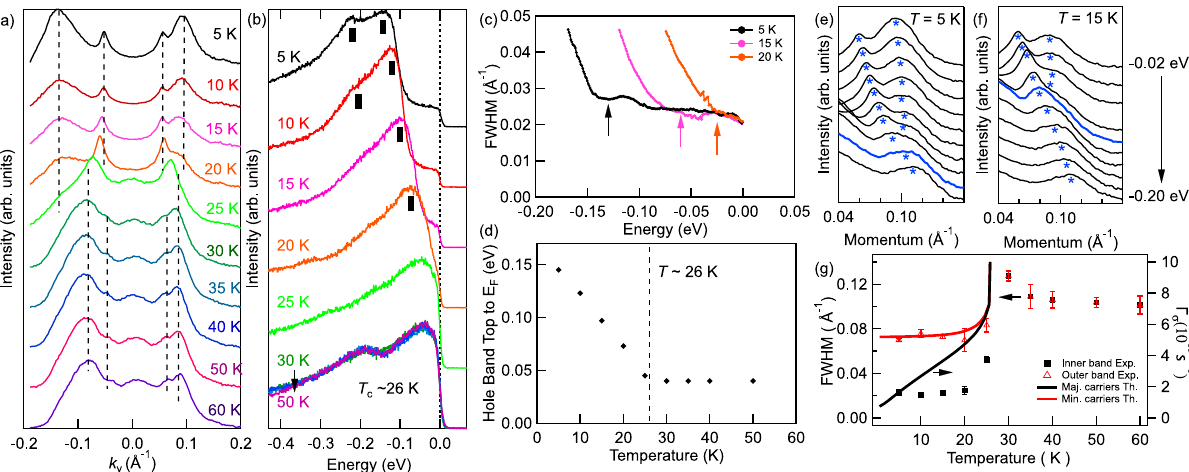
Fig. 3 Detailed temperature evolution of the electronic structure of EuCd 2 As 2 obtained using ARPES. a MDCs at the Fermi energy measured at temperatures between 5 and 60 K. The dashed lines are a guide to eye-marking locations of MDC peaks. Comparing peak position at T ≥ 25 K and T = 5 K, note that hole peak (spin) splits into two peaks in opposite directions. b EDCs at k y = 0 at temperatures between 5 and 50 K. Black lines mark locations of peaks. Note that the central peak is (spin) split into two at low temperatures. c Full-width half maximum (FWHM) data obtained from Lorentzian fi ts to the MDCs for the inner hole band showing signi fi cant reduction of scattering (enhancement of lifetime) for energies slightly above the top of the fully occupied band, which are marked by arrows. d The binding energy of the fully occupied hole band top as a function of temperature. e , f MDCs at 5 and 15 K, respectively, for the right side of hole bands close to energies marked as blue stars in Fig. 2; − 0.02 to − 0.20 eV with 0.02 eV steps. Blue stars indicate the peak position. MDCs for which the two peaks merge are marked in blue. g FWHM of the MDC peaks on the left side in ( a ) as a function of temperature. Red triangles represent the very left peak (broad outer band), and black squares represent the second left peak (sharp inner band). Error bars represent the standard deviation of fi tting the width of the peaks. The solid lines are theory results of the spin-dependent scattering rates of minority (red) and majority (black) carriers. We fi nd good agreement under the assumption that the width in energy and in momentum space is proportional to each